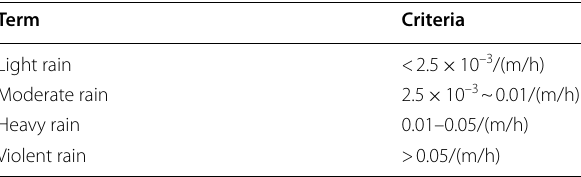
Table 6 Classification criteria of rainfall intensity (Cheng et al.